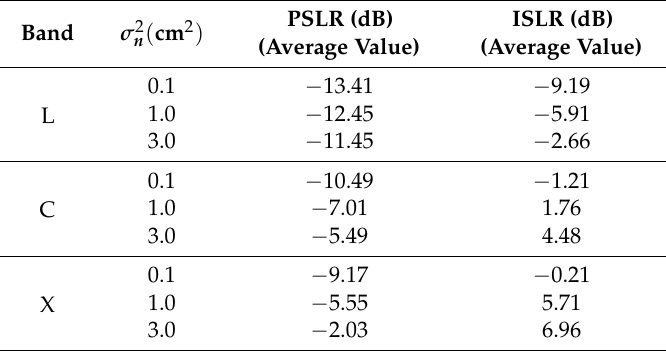
Table A1. Evaluations of azimuth profiles of point target under L-, C-, and X-bands (integration time is 100